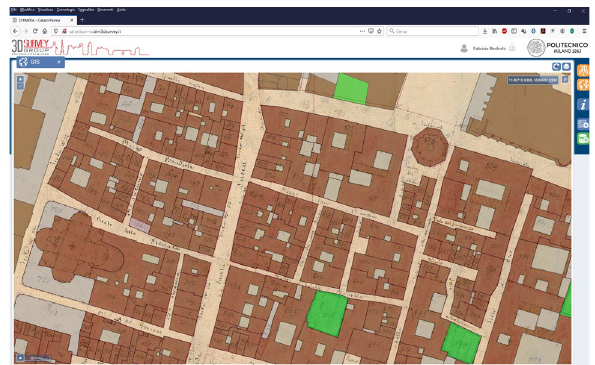
Figure 5 – GIS component working with raster historical maps and vector layers for historical cadaster of